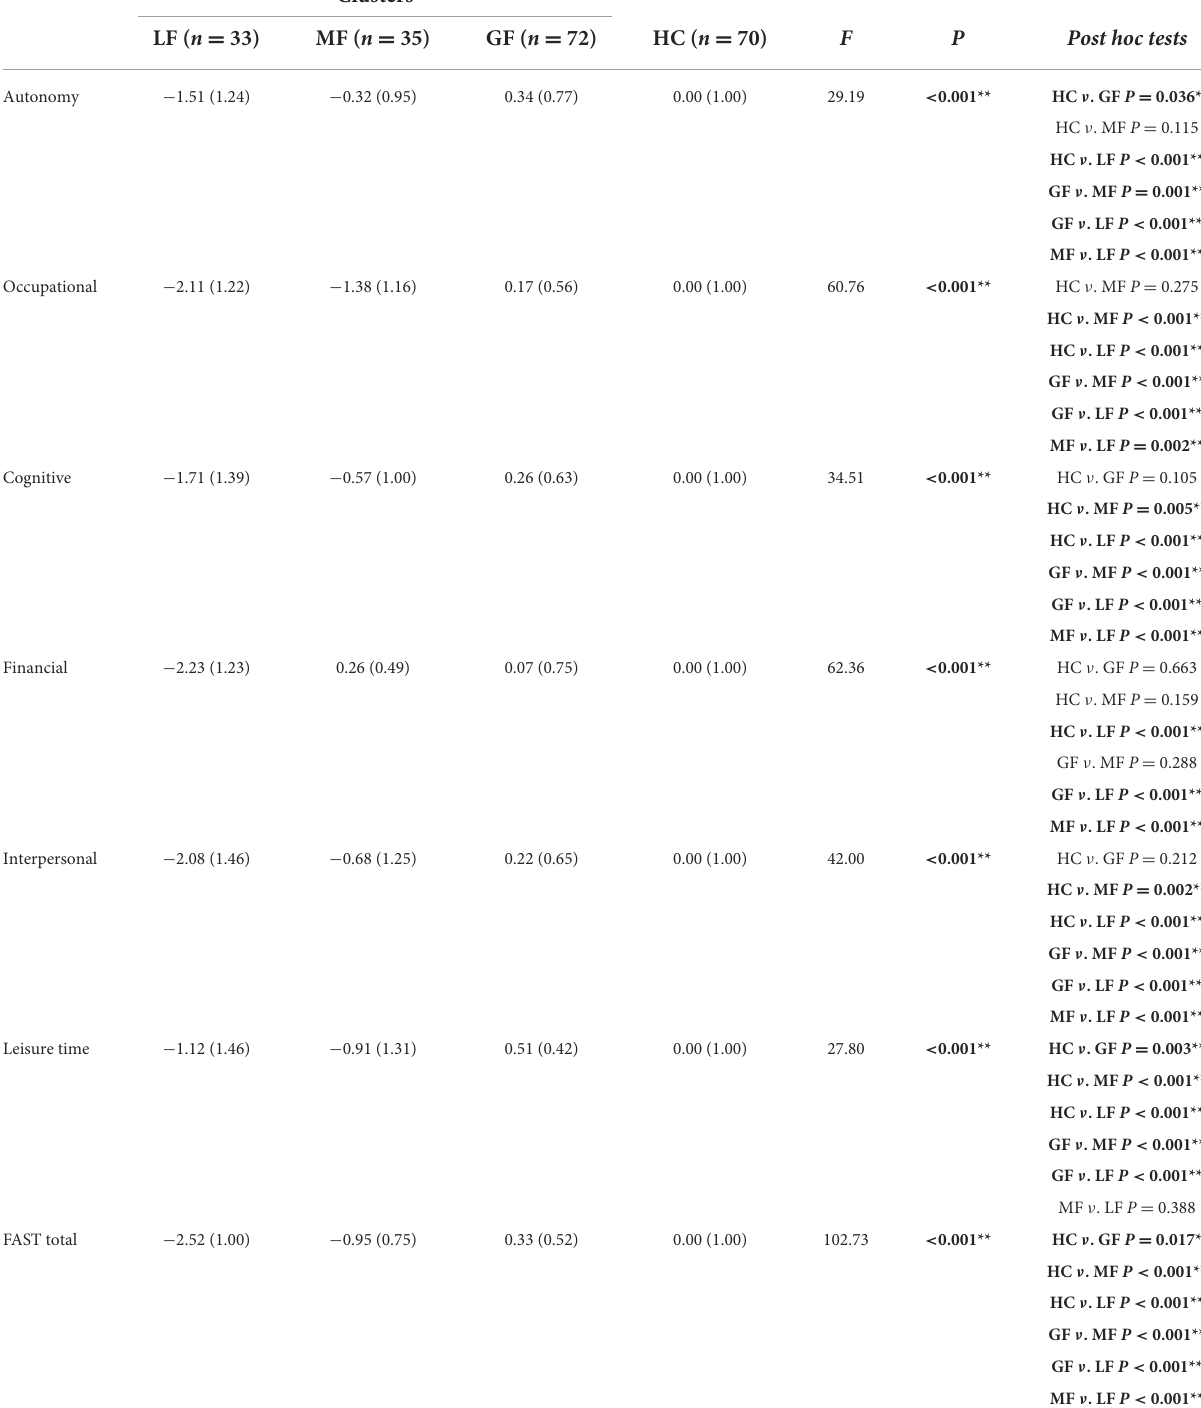
TABLE 2 Comparisons between FAST domains according to three functional clusters and HCs ( Z